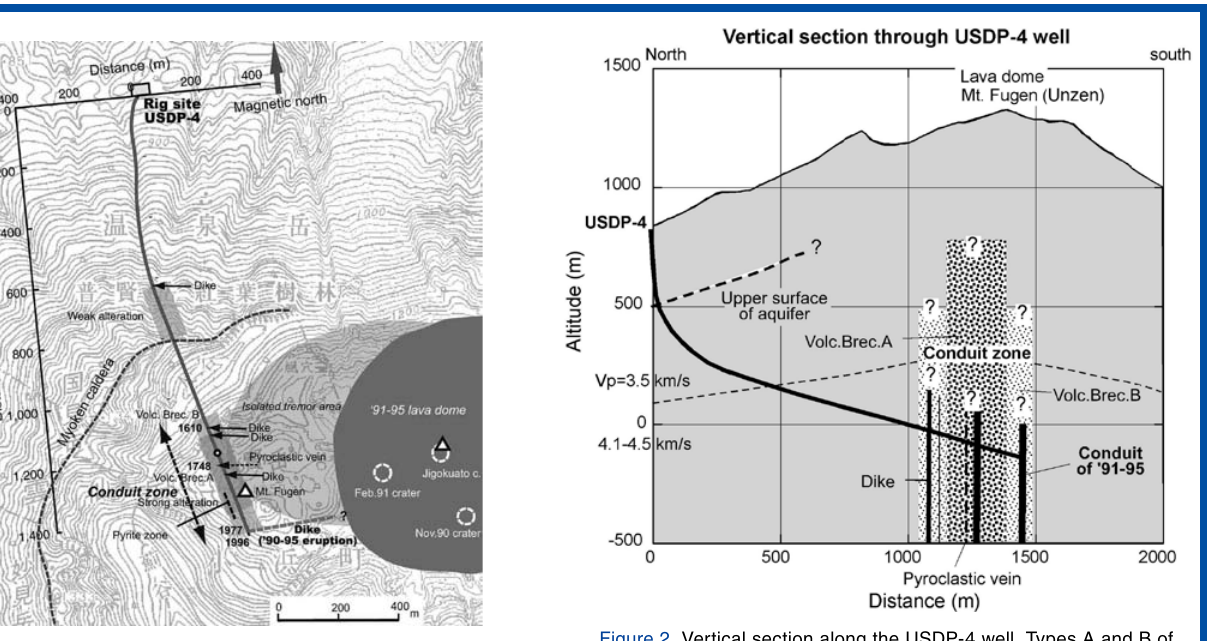
Figure 1. Map showing the summit area of Unzen Volcano and the plane view of the USDP-4 trajectory. The conduit zone, consisting of multiple lava dikes and pyroclastic veins in homogeneous volcanic breccia (vent breccia), is as thick as 0.5 km under the volcano summit. A small circle on the trajectory line was the drilling target (at sea level) of the 2004 operation.